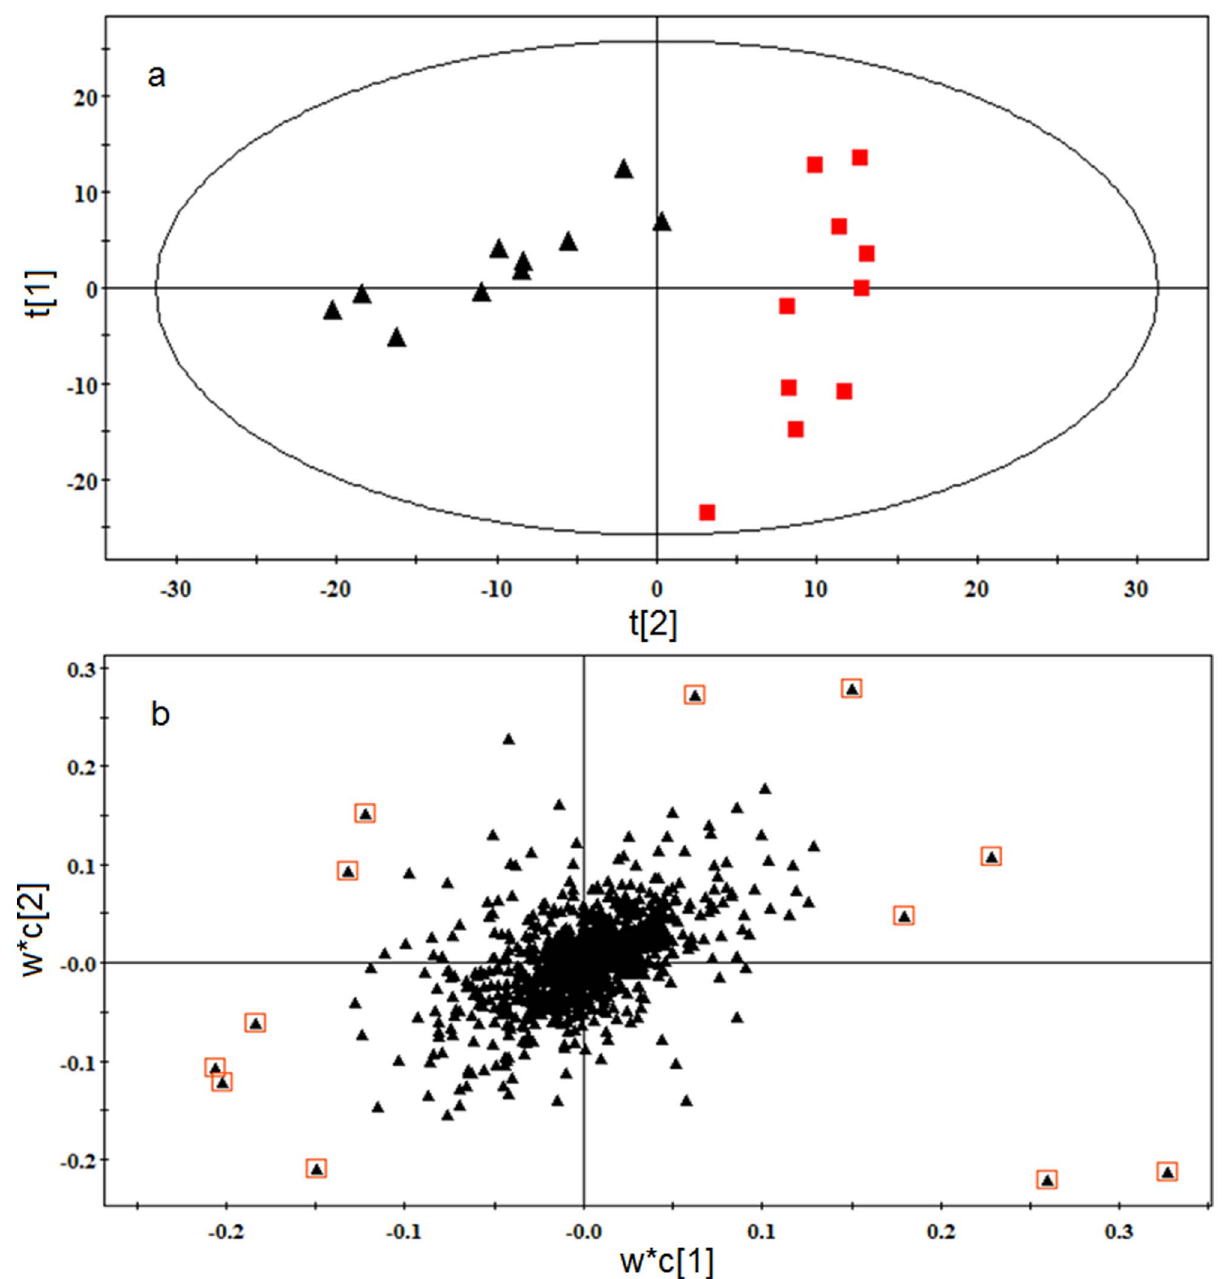
Figure 3. (a) OPLS score plot of the SLE model group ( m ) and control group ( & ). (b) OPLS loading plot of the SLE model group and control group. The 12 metabolites far from the origin that contributed significantly to differentiating the clustering of the SLE model group from the control group were defined as differential metabolites.